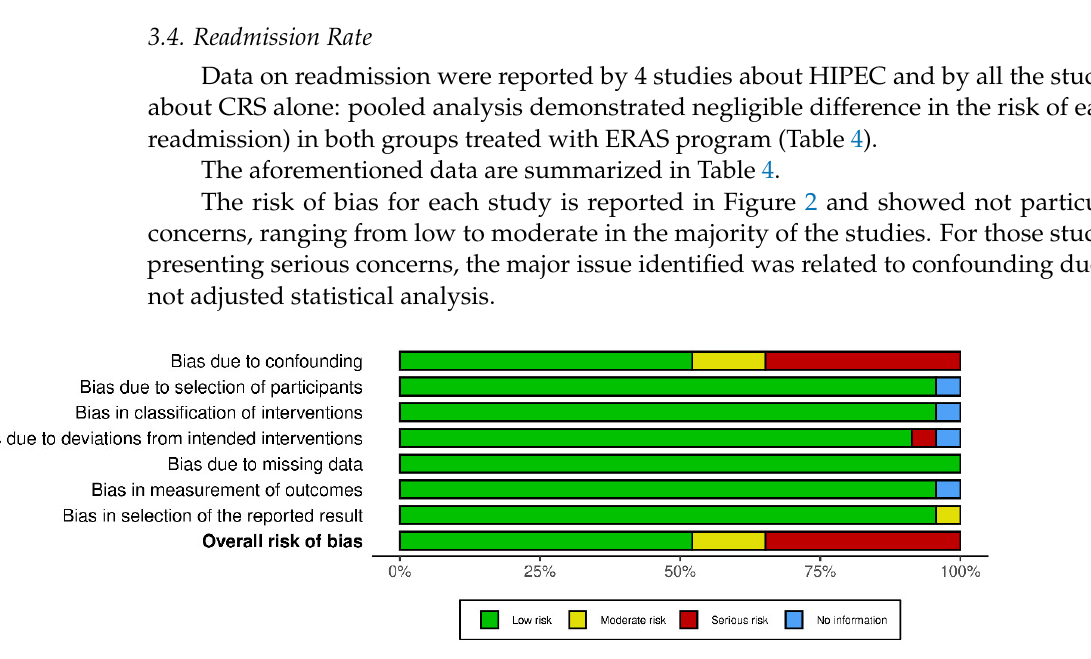
Figure 2. Risk of bias of the studies: traffic light plot.